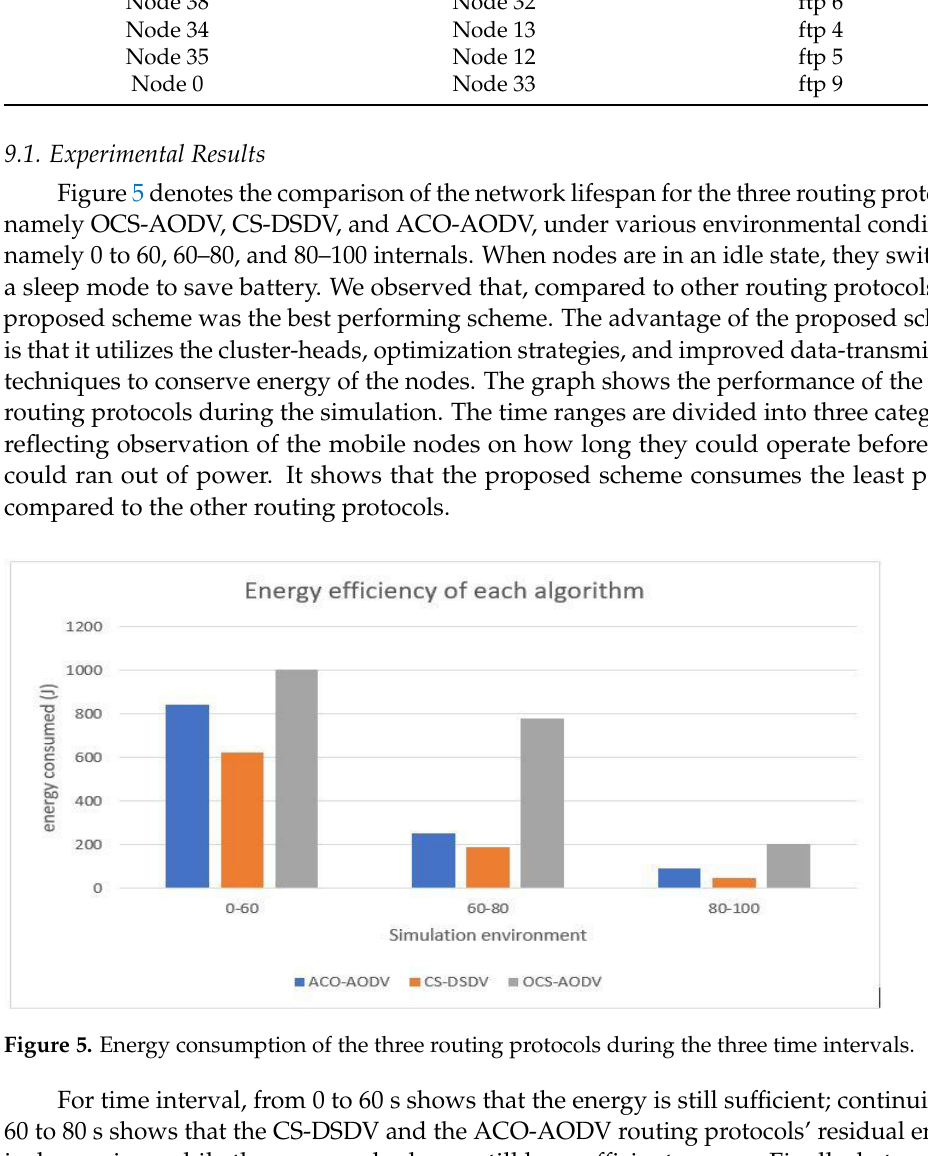
Figure 6. Packet Lost and Packet Delivery Ration Results for the three routing protocols: ( a ) The Packet delivery Ratios of the three Routing Protocols ( b ) Number of Packets Lost during the Simulation. 9.2. Scenario 1 Results Figure 6a depicts the simulation results of the proposed OCS-AODV routing scheme and it was compared to CS-DSDV and ACO-AODV protocols. The proposed scheme achieved the best performance because of the effectiveness of its OCS technique. A se- lected path tends to be optimal. Hence, the scheme delivered more packets than the other schemes. The study observed that the CS-DSDV protocol performed badly throughout the simulation due to nodes moving away from their original location, exiting the network, and others joining the network. This causes frequent reconfiguration of mobile nodes as they keep updating each other about the state of the network. So, the scheme is subjected to link breakages whereas, after a link breaks, it also fails to rediscover the link quickly. The study did not use the congestion control or avoidance mechanism to stabilize the traffic load accordingly. When the number of nodes increased within the network, the proposed scheme experienced a decrease in PDR. The nature of ACO-AODV iteration can prohibit the use of ongoing applications while the ant-colony optimization takes an ex- ceptionally long time to converge; thus, the two protocols were outperformed by the cuckoo search algorithm. The packet loss occurs when packets are sent across the network and are not deliv- ered to their destination. Figure 6b presents the outcomes of the packets lost throughout